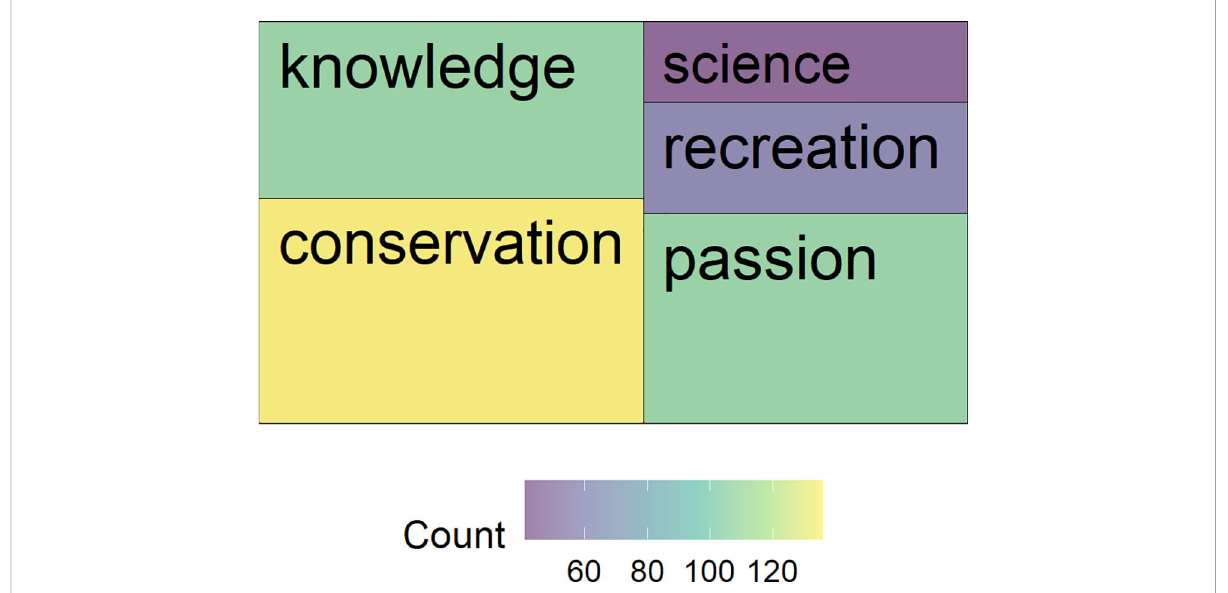
FIGURE 2 Participant motivations for joining community science projects. The number one motivation was contributing to conservation (46%), followed by personal passion and gaining knowledge, which tied for second (36%).